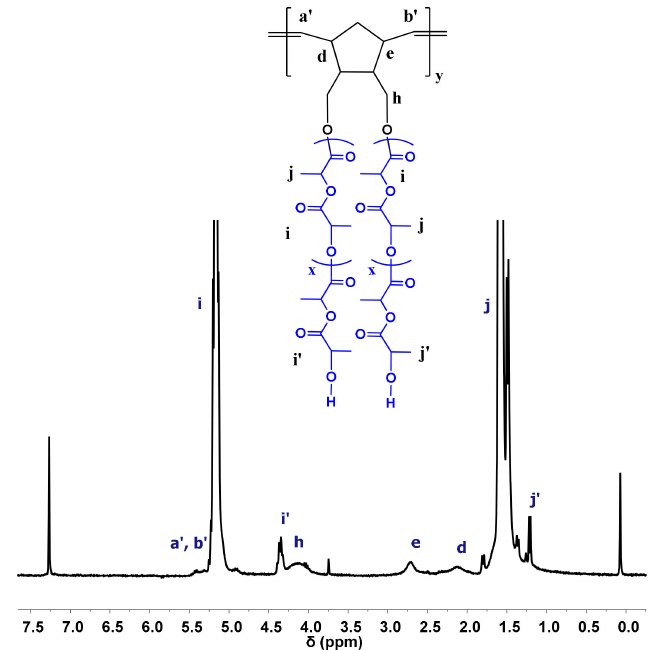
Figure 7. 1 H NMR spectrum of sample DB-PLLA in CDCl 3